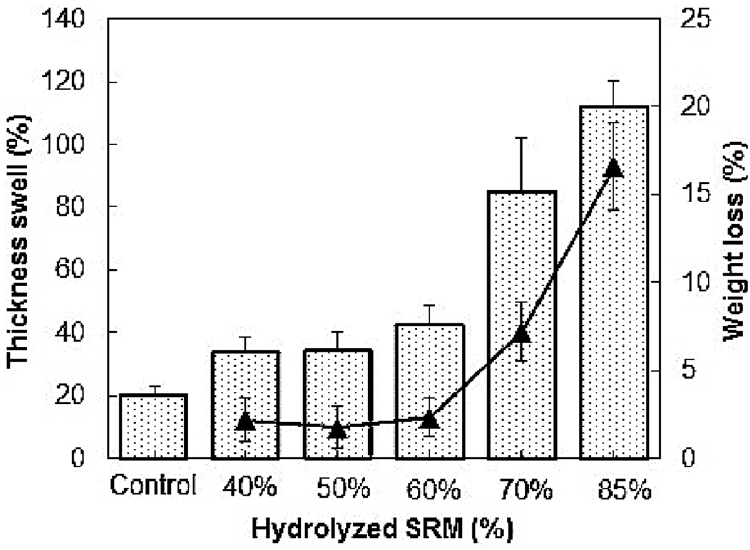
Figure 4. Percentage thickness swell of OSB panels and weight loss of adhesive as a function of the percentage of hydrolyzed SRM in the adhesive formulation. The bar graph shows the thickness swell of OSB panels using hydrolyzed protein adhesives cured with 4,4-diphenylmethane diisocyanate. The scattered line chart shows the weight loss of the cured adhesive in water as the hydrolyzed protein concentration was varied from 0 % to 85%. Figure adopted with copyright permission from Wiley-VCH (for Mekonnen et al., 2014).